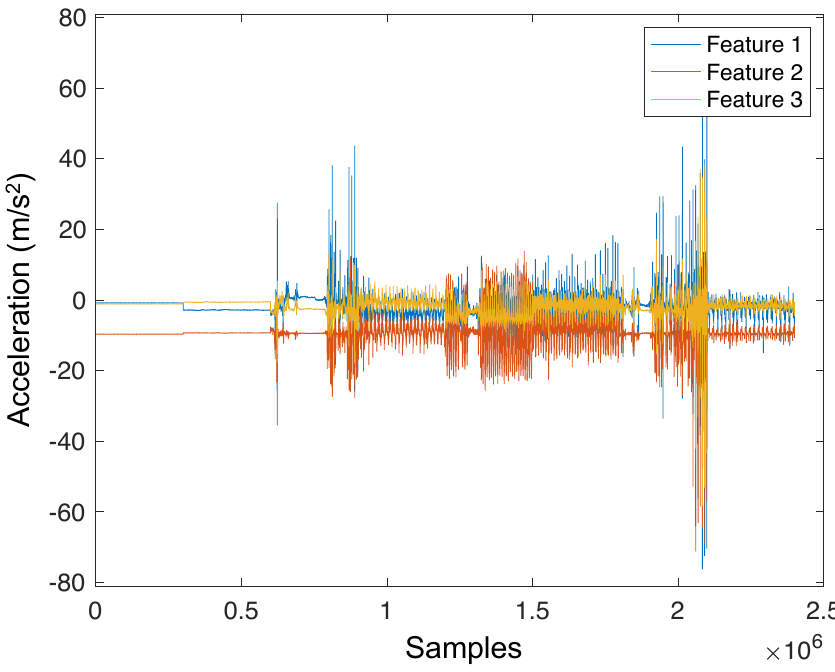
Figure 3. Accelerometer sensor features on 3 axes for each of the